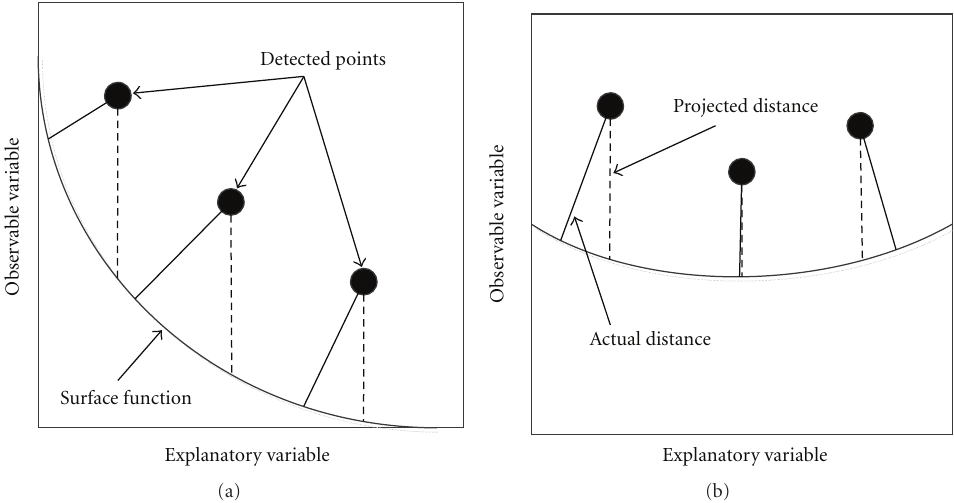
Figure 4: Estimating distances from a set of surface points to an estimated surface in (a) the original coordinate system, the error estimated by the observable variable (dashed lines) di ff ers greatly from the actual error (solid lines), but if (b) the pleural surface is parallel to the explanatory variable plane, the error estimated by the observable variable provides a good approximation to the actual error.